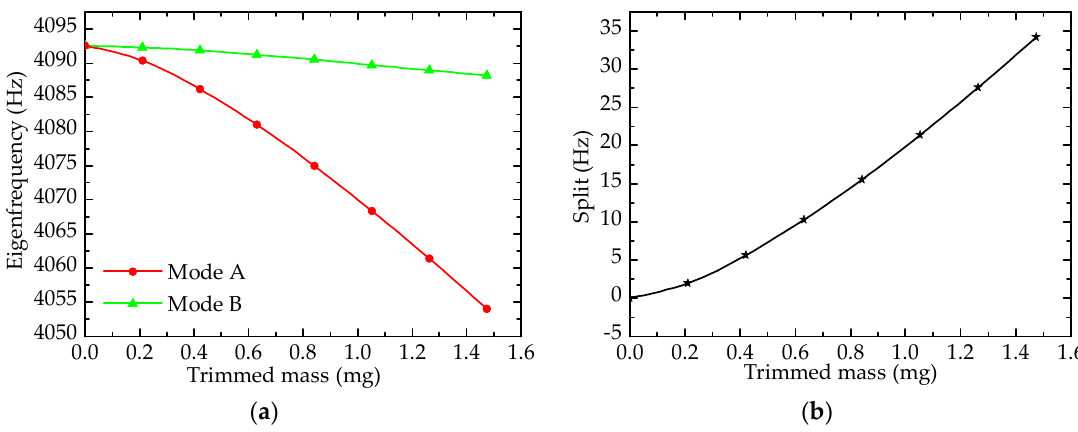
Figure 7. Effect of forming grooves on eigenfrequency: ( a ) Eigenfrequency; ( b ) Frequency split.